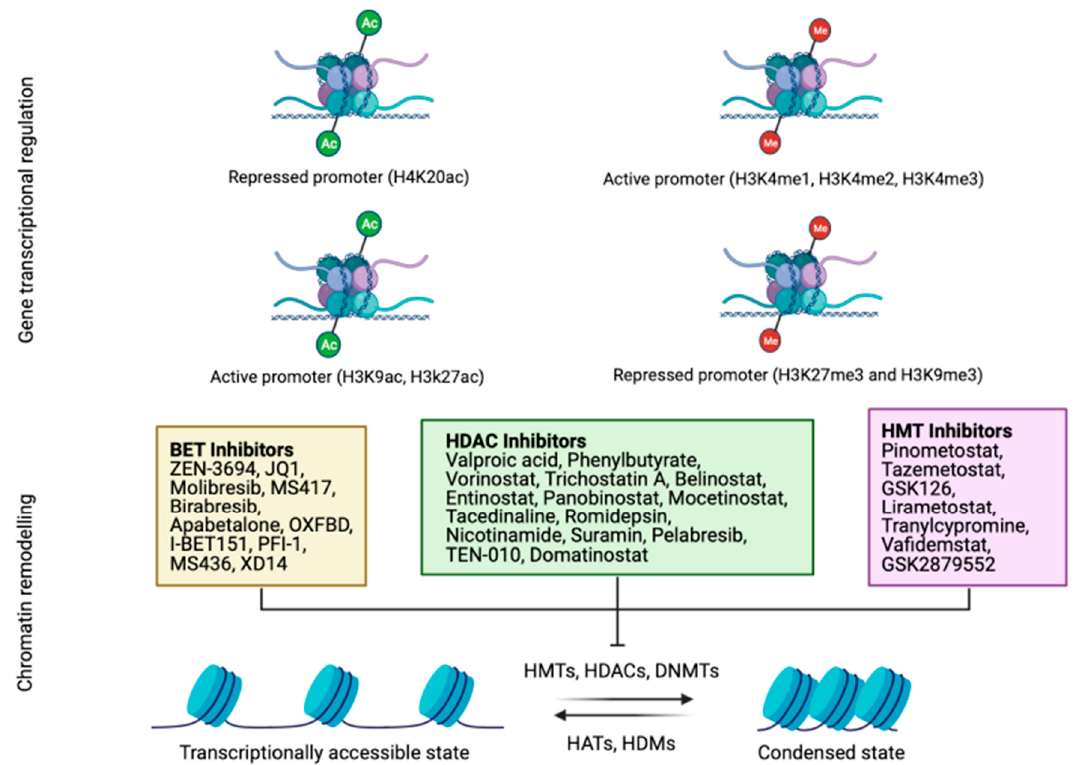
Figure 2. Schematic representation of the main histone modification processes. Both acetylation and methylation positively and negatively regulate gene transcription according to the methylated or acetylated residue (up). Several drugs have been designed to allow chromatin remodeling by the inhibition of BET, HDAC or HMT proteins that condense chromatin and hamper transcription (down). Histones acetylation and cytosines unmethylation will result in an open chromatin structure and gene transcription is active. BET: bromodomain and extra-terminal motif (BET) proteins. HDAC: histone deacetylases. HMT: histone methyltransferase. DNMTs: DNA methyltransferases. HAT: histone acetyltransferase. HDM: histone demethylase.